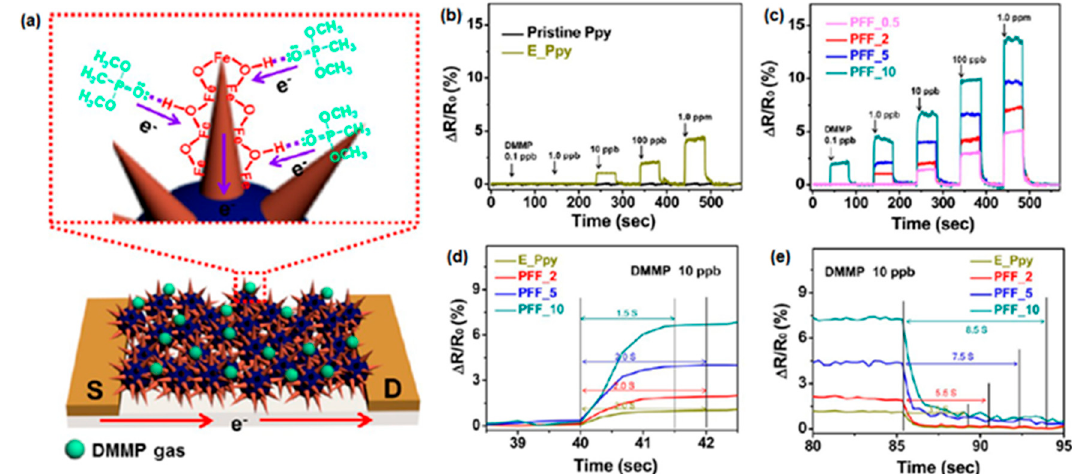
Figure 6. ( a ) DMMP gas detection mechanism of hybrid FeOOH nanoneedles on the PPy nanoparticles at room temperature. Reversible and reproducible responses are measured at a constant current value (10 − 6 A) with various amounts and types of FeOOH on the PPy surfaces. Normalized resistance changes upon sequential exposure to various DMMP concentrations of ( a ) pristine (black), E_PPy (yellow), and ( b ) hybrid PFF nanoparticles (pink, PFF_0.5; red, PFF_2; blue, PFF_5; green, PFF_10). The ( c ) response and ( d ) recovery times of hybrid PPy nanoparticles (yellow, E_PPy; red, PFF_2; blue, PFF_5; green, PFF_10) at 10 ppb of DMMP gas at room temperature. ( e ) The PFFs with 0.5, 2.0, 5.0, and 10.0 wt % FeOOH precursors are denoted as PFF_0.5, PFF_2, PFF_5, and PFF_10, respectively. Reprinted with permission from [47]. Copyright 2013, American Chemical